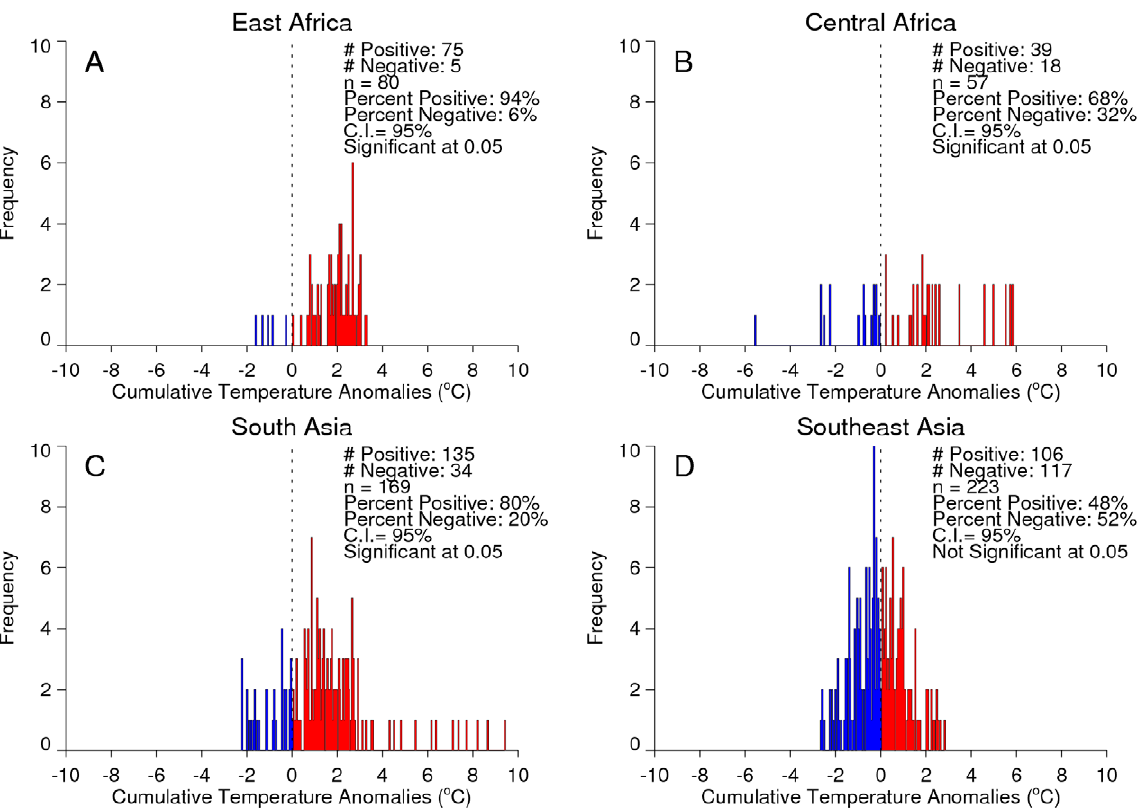
Figure 6. Frequency distributions of chikungunya outbreak events in relation to temperature. Frequency distributions of chikungunya outbreak events and 4-month cumulative temperature anomalies for East Africa (A), Central Africa (B), South Asia (C), and Southeast Asia (D). The 4- month anomaly threshold was used to represent periods of either cool temperatures or drought and extreme high temperatures The dashed line at zero depicts the 1979–2009 long-term mean temperature, with warmer-than-normal temperatures shown to the right (red) and cooler-than-normal temperatures shown to the left (blue) of the line. Cases shown to the right of the dashed line occurred during periods of elevated temperature with a persistence of 4